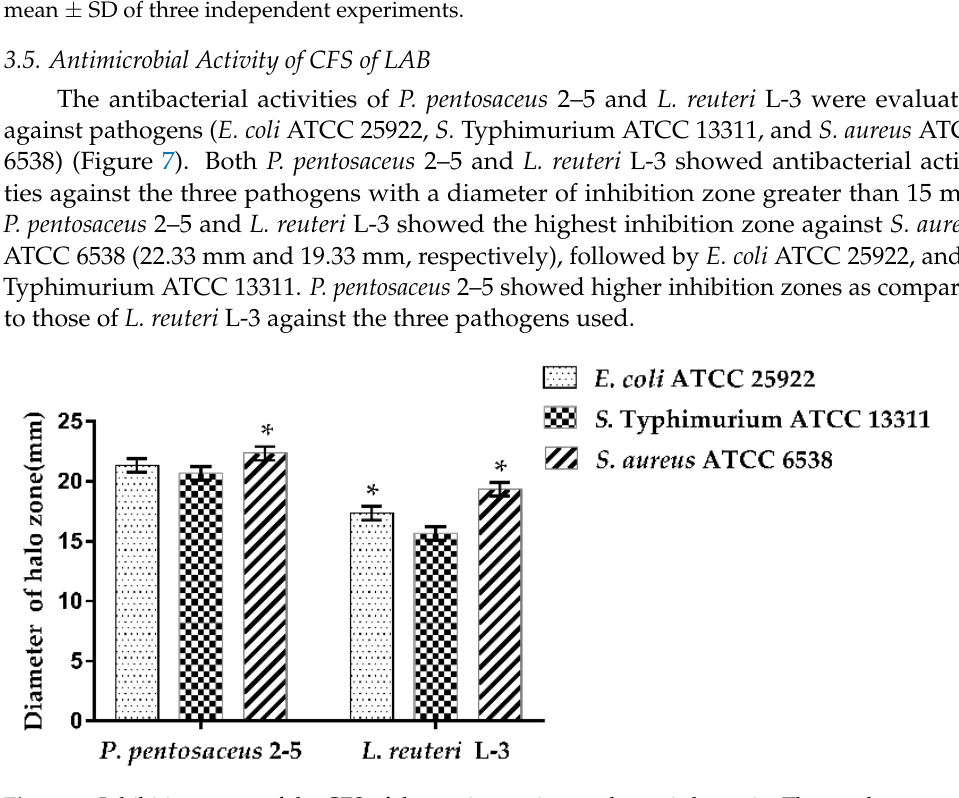
Figure 7. Inhibition zones of the CFS of the strains against pathogenic bacteria. The results represent the mean ± SD of three independent experiments. The significant difference was indicated by asterisks compared to LAB against S. Typhimurium ATCC 13311: * p <0.05.